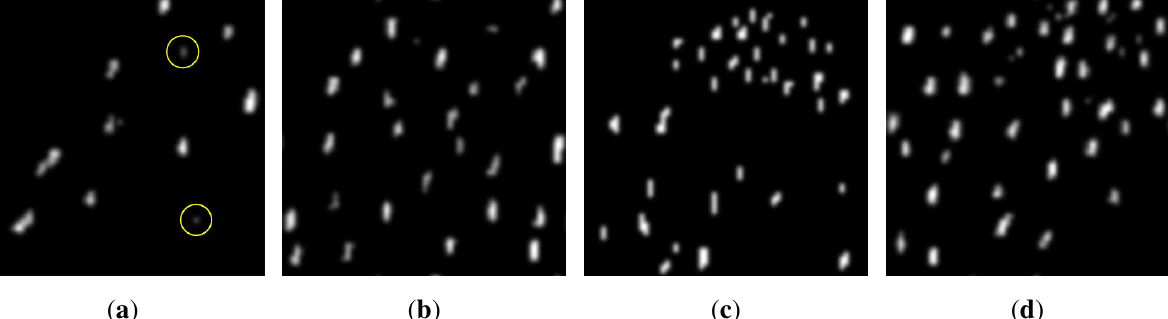
Figure 6. Heterogeneity feature maps ( H